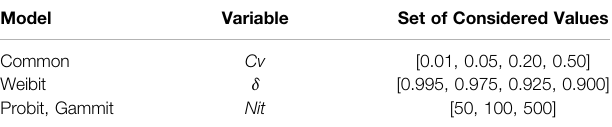
TABLE 4 | Considered values of the independent variables.